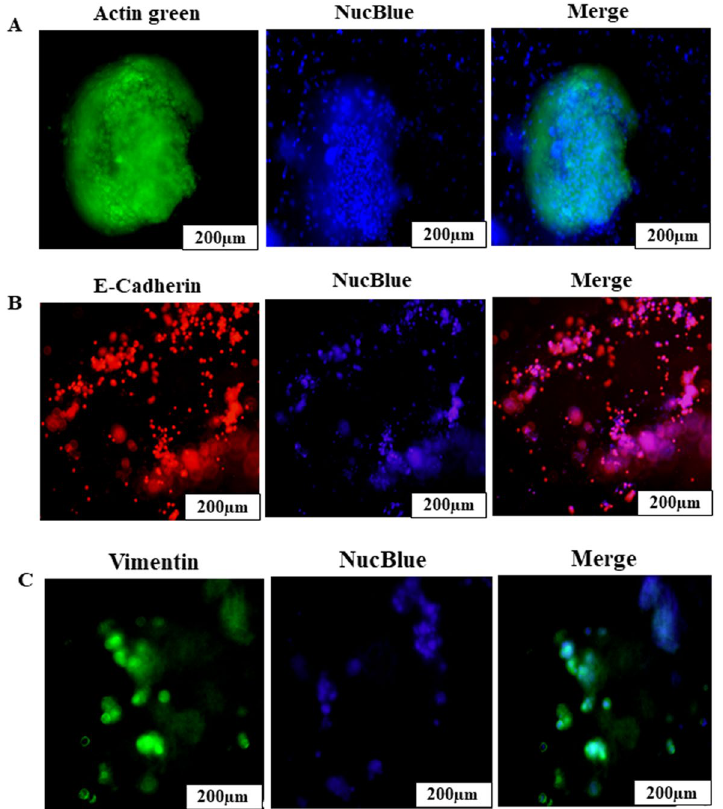
Figure 8. 3D spheroids formation in printed ink H4-RGD NSCLC-PDX cell laden scaffolds. ( A ) Spheroid formation in NSCLC-PDX cells with ink H4-RGD on the 7th day after staining with NucBlue/Actin Green staining. ( B ) Immunofluorescence staining for E-cadherin in printed NSCLC-PDX laden scaffold with ink H4-RGD; ( C ) Immunofluorescence staining for Vimentin in printed NSCLC-PDX laden scaffold with ink H4-RGD. Microscopic images were acquired by using Olympus Microscope IX71 and cellSens Standard software (version 1.16; Tokyo, Japan).